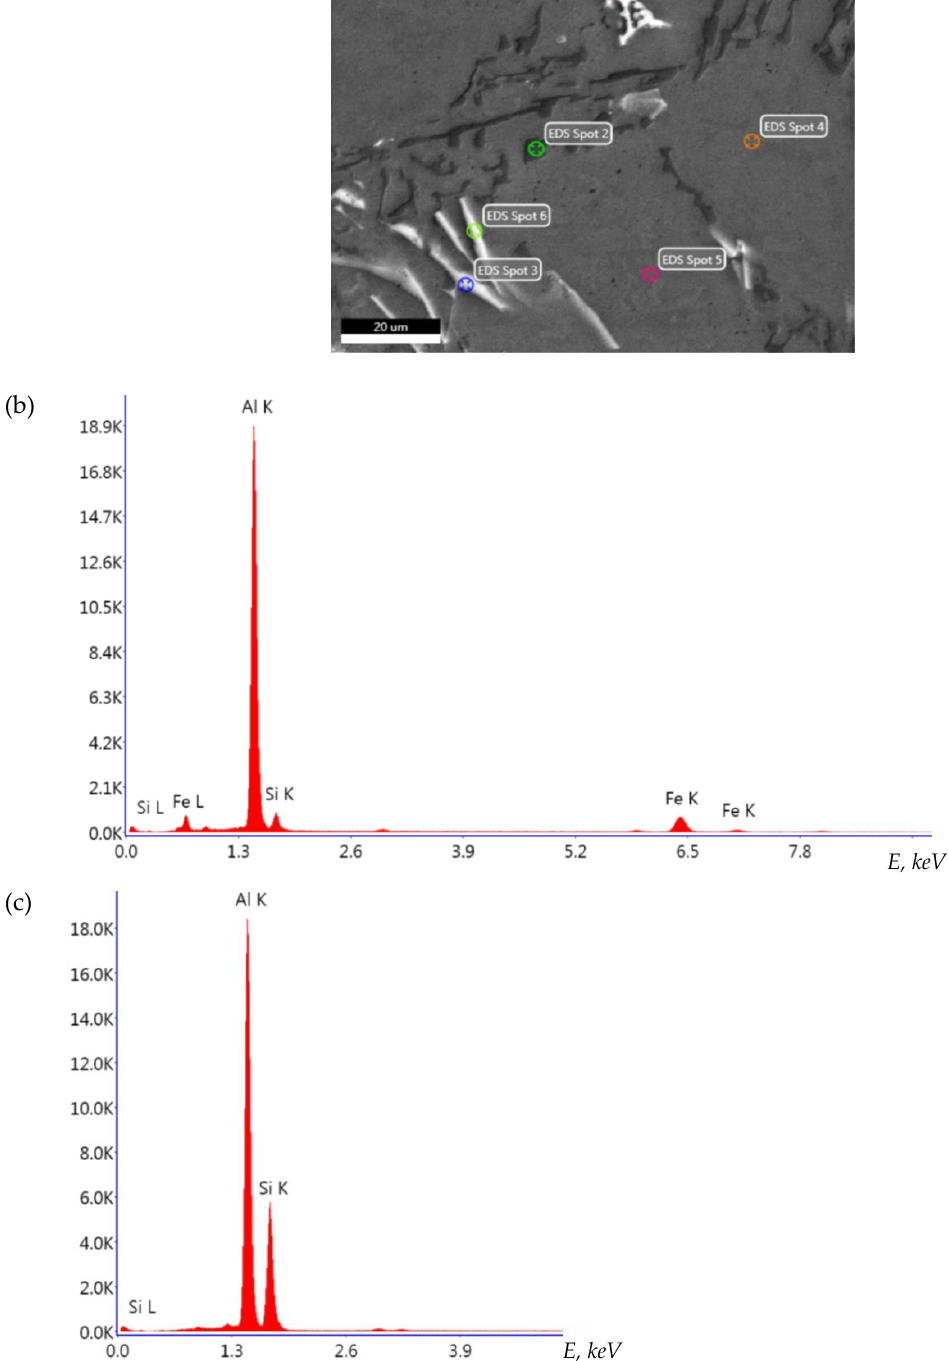
Figure 12. ( a ) EN AC–AlSi11 alloy microstructure in the initial state with marked EDS-analysed microareas. Images of the ( b ) EDS Spot 1, ( c ) EDS spot 2 microareas EDS spectrum.